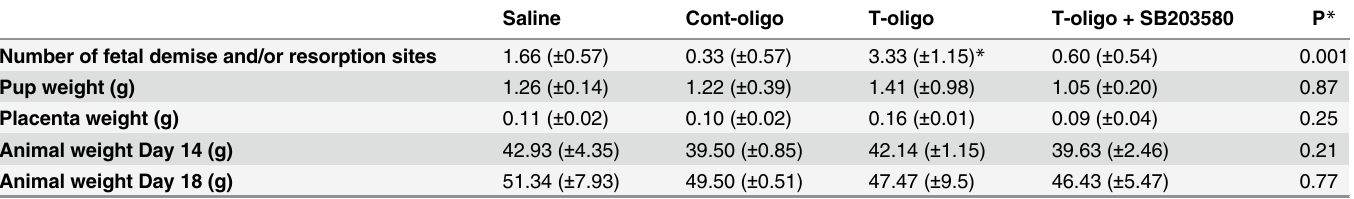
Table 2. Descriptive data from studied CD-1 pregnant mice according to treatments groups (n = 5 animals/group): Saline, Cont-Oligo, T-oligo and T-oligo co-treatment with SB203580.